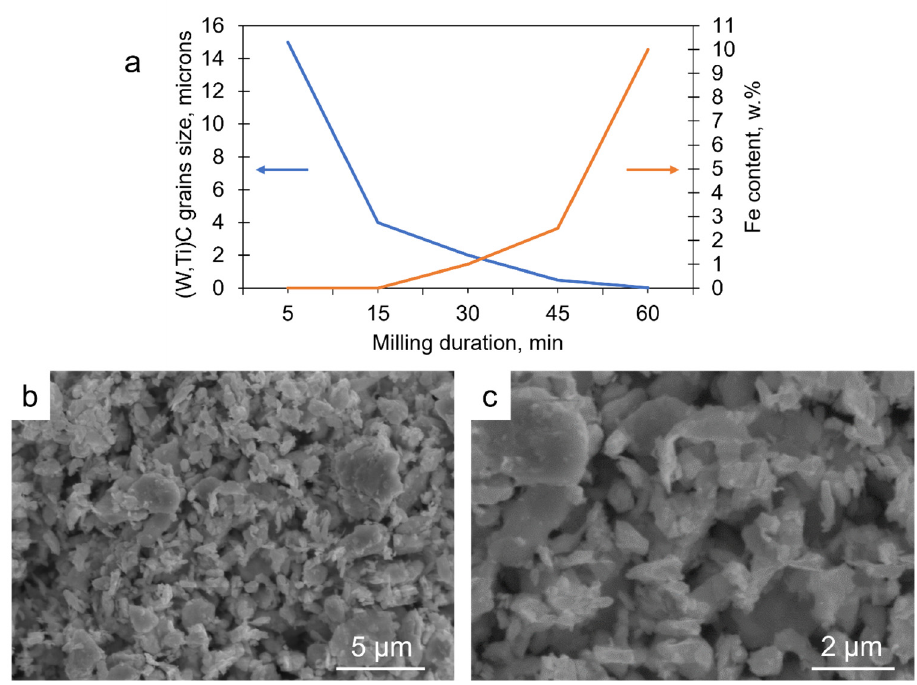
Figure 9. Dependence of grain size and Fe content on the duration of the mechanochemical synthesis ( a ); SEM micrographs of the (W, Ti)C powders after 15 min milling ( b , c ). To ascertain the mechanism of formation of the (W,Ti)C solid solution during the